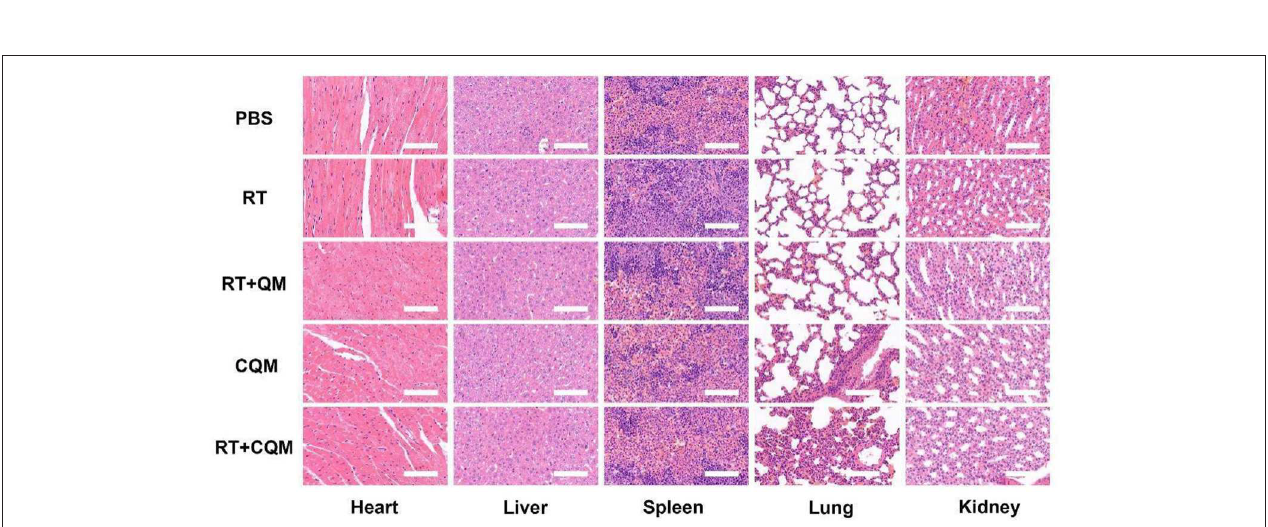
FIGURE 4 | Results of histopathological analysis (H&E stained images) of the major organs; heart, liver, spleen, lung, and kidney, of mice who received various treatments 16 days post-injection under laser irradiation conditions (scale bars: 100 µ m).